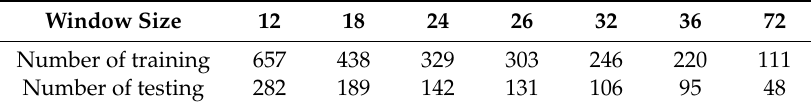
Table 3. Window size vs. the numbers of training and testing